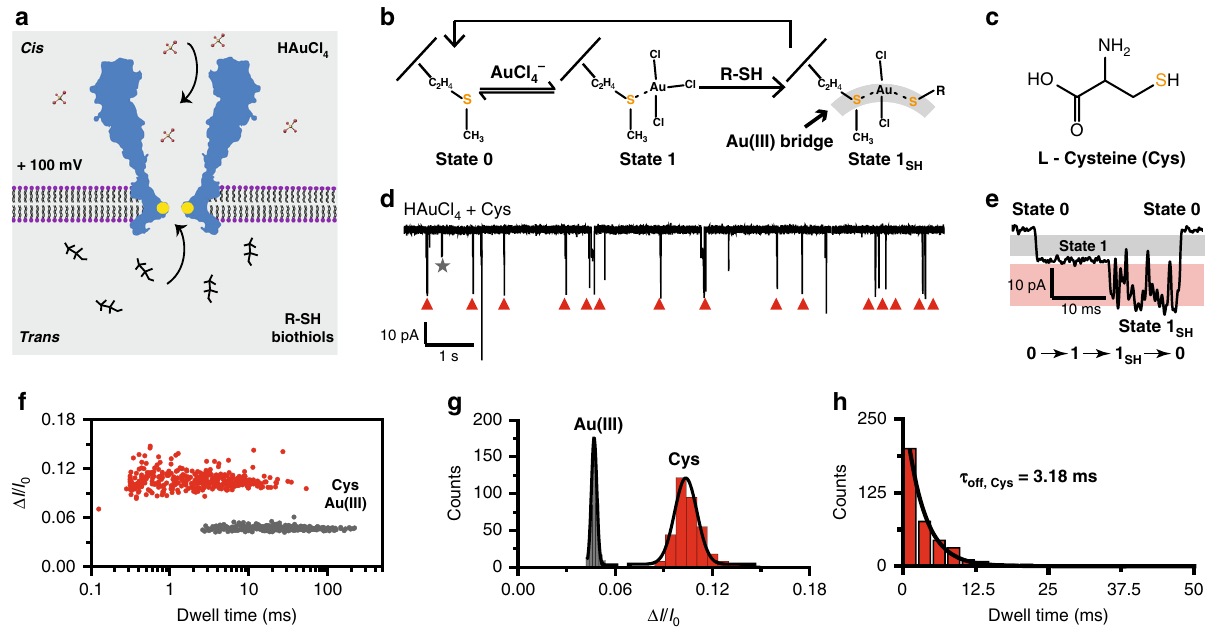
Fig. 3 Stochastic sensing of L-cysteine by Au(III) embedded MspA-M. a A general schematic diagram of biothiols sensing. HAuCl 4 were added in cis while the biothiols (R-SH) were added in trans . R represents the chemical structure of a speci fi c type of biothiol other than the thiol group. b A molecular model for biothiols sensing. State 0 or 1 represents a methioine residue, without or with a [AuCl 4 ] − embedment. State 1 SH represents a biothiol bound with the pore restriction by taking the embedded Au(III) as an atomic bridge. c The chemical structure of L-cysteine (Cys). L-cysteine is a speci fi c type of biothiol. d Binding of Cys with [AuCl 4 ] − embedded MspA-M. The trace was recorded with a + 100 mV applied voltage when 4 μ M of HAuCl 4 in cis and 40 μ M of Cys in trans were present simultaneously. Resistive pulse signals in the trace result from binding of a [AuCl 4 ] − or binding of a Cys by taking the bound Au(III) as an atomic bridge. Red triangles mark the events from Cys. The grey star marks the event of [AuCl 4 ] − . Other unlabeled events are background signals as described in Supplementary Fig. 15. e A representative Cys blockage event. A representative Cys blockage event is composed of three states as described in b . State 1 SH appears as a characteristic jitter signal. f The scatter plot of the relative blockade amplitude Δ I / I 0 vs the dwell time from events of [AuCl 4 ] − and Cys binding. The event amplitude ( Δ I ) for [AuCl 4 ] − or Cys is de fi ned as the current difference between state 1 or state 1 SH in reference to state 0 (Supplementary Fig. 16). I 0 is the open pore current, which was derived from the mean value of state 0. g The histogram of Δ I / I 0 for single [AuCl 4 ] − bindings and Cys bindings. h The histogram of the dwell time of state 1 SH ( t off , Cys ) from a series of Cys binding events. The mean dwell time τ fi tting result. The statistical data in f , g , and h were from a continuous 10 min recording (Methods). off , Cys was derived from the single exponential (Supplementary Tables 5 and